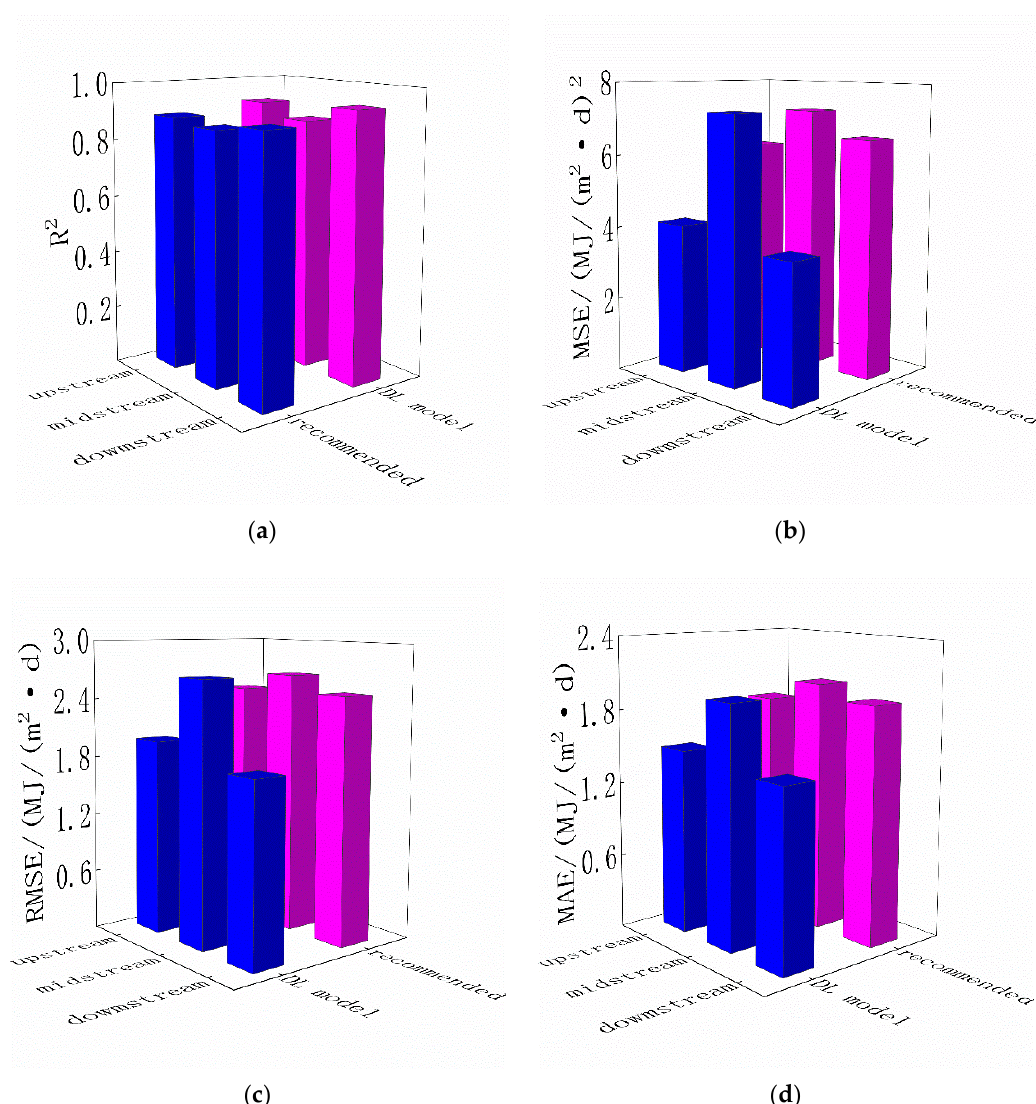
Figure 2. ( a ) The determination coefficient R 2 values of the prediction results of the recommended Å-P parameters and the DL model in the upstream, midstream and downstream of the Yellow River Basin; ( b ) The mean square error MSE values of the prediction results of the recommended Å-P parameters and the DL model in the upstream, midstream and downstream of the Yellow River Basin; ( c ) The rooted mean square error RMSE values of the prediction results of the recommended Å-P parameters and the DL model in the upstream, midstream and downstream of the Yellow River Basin; ( d ) The mean absolute error MAE values of the prediction results of the recommended Å-P parameters and the DL model in the upstream, midstream and downstream of the Yellow River